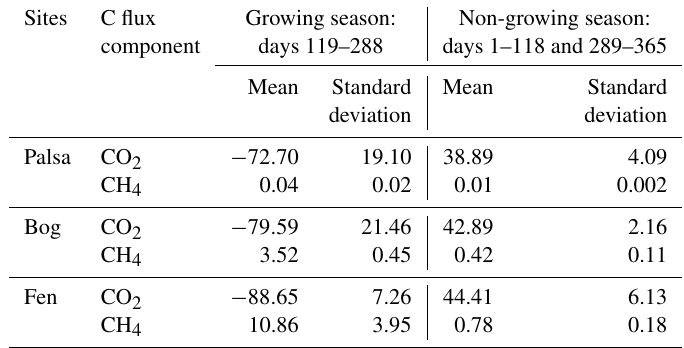
Table 3. Means and standard deviations of cumulative CO 2 and CH 4 exchanges simulated in the palsa, bog, and fen during the period 2003 to 2007.